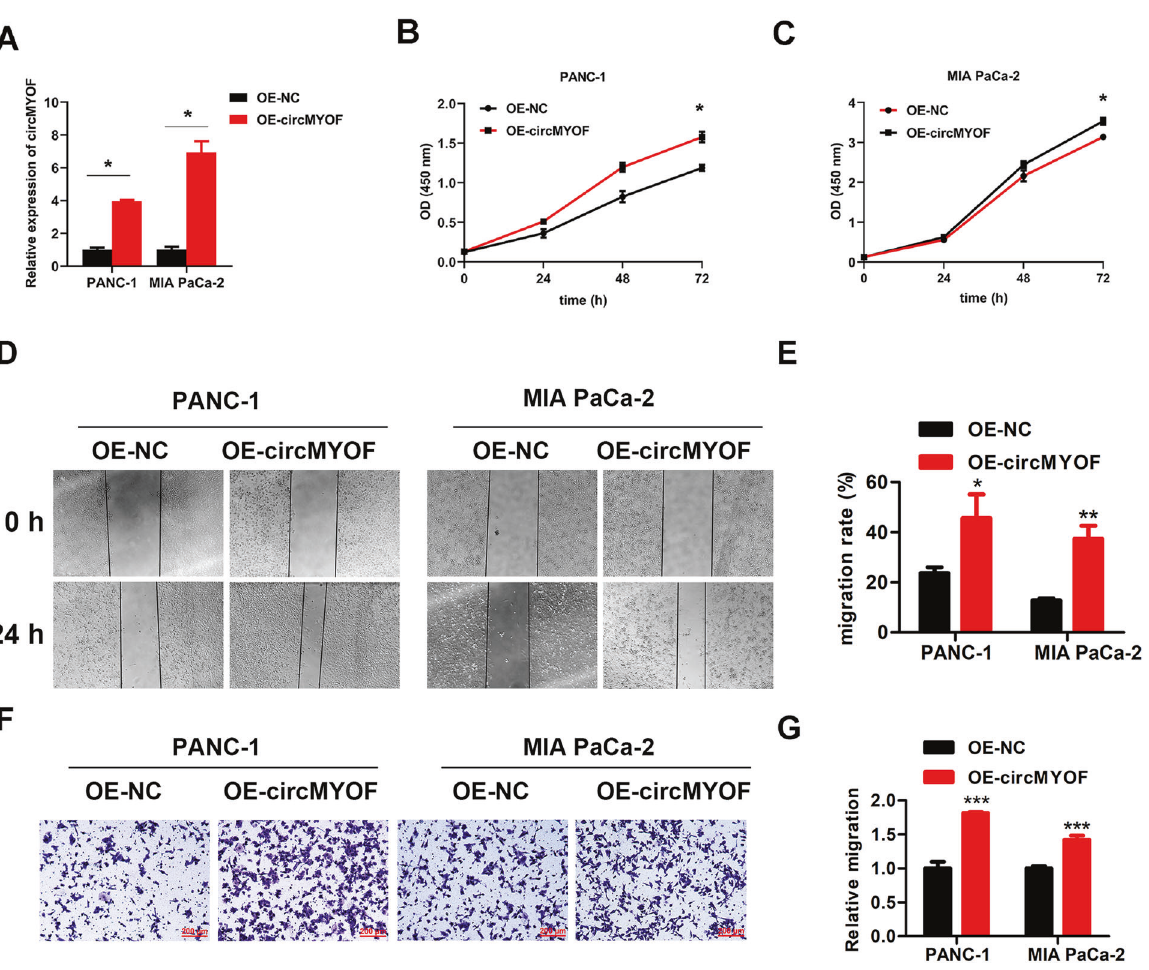
Fig. 2 Overexpression of circMYOF promotes cell growth and metastasis in PDA in vitro. A CircMYOF was stably overexpressed in MIA PaCa-2 and PANC-1 cells. Effective upregulation of circMYOF was con fi rmed by PCR. B, C Cell proliferation ability was evaluated using the CCK- 8 assay. Growth curve analysis illustrated that enhanced expression of circMYOF triggered proliferation in PANC-1 ( B ) and MIA PaCa-2 cell ( C ) with OE-circMYOF vectors. D , E PANC-1 and MIA PaCa-2 cells expressing OE-NC or OE-circMYOF were subjected to wound healing assays. Overexpression of circMYOF promoted metastatic potential in PDA. F , G Transwell assays indicated that circMYOF overexpression led to enhanced cell migration. Scale bars: 200 µm. Data are presented as the mean ± SD. All research was carried out triply. * p < 0.05, ** p < 0.01, ** * p <